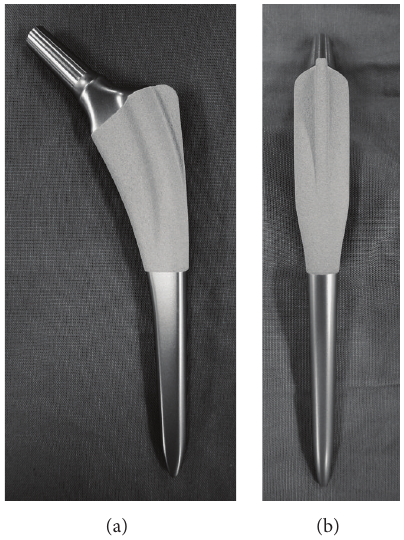
Figure 1: Anterior (a) and lateral (b) views of the cementless stem